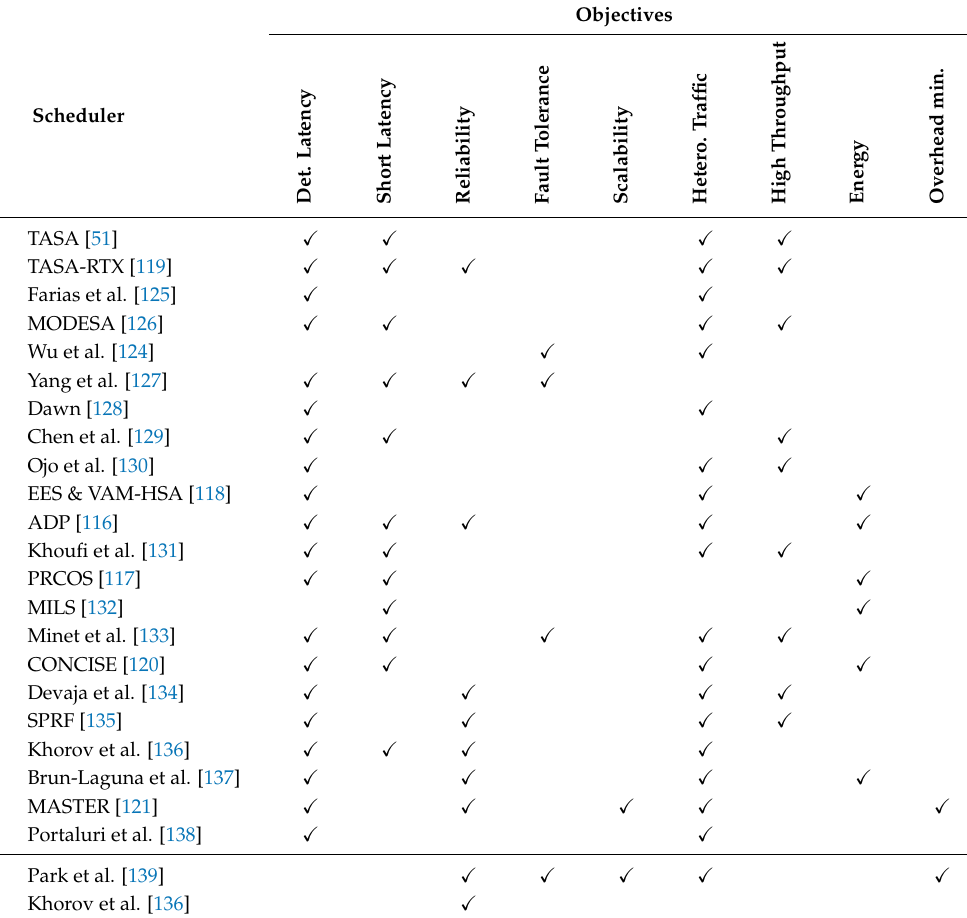
Table 8. Evaluation of centralized and static (bottom)